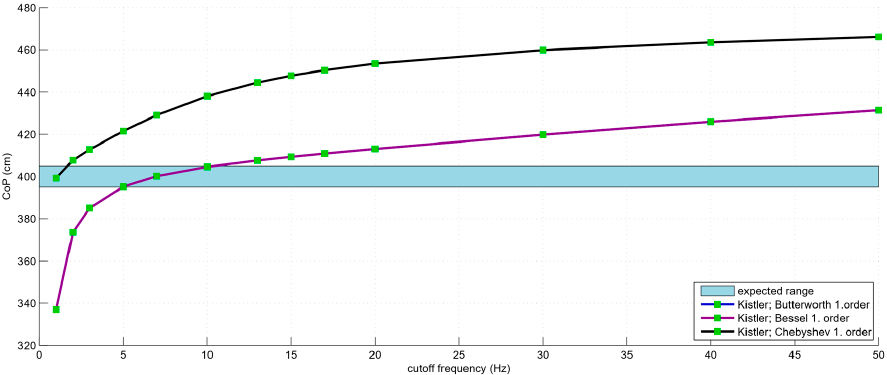
Figure 4. Representation of characteristic curves of first-order Bessel, Butterworth, and Chebyshev filters. The Butterworth (blue) and Bessel filters (magenta) possess the same behavior, so the characteristic curves are congruent.